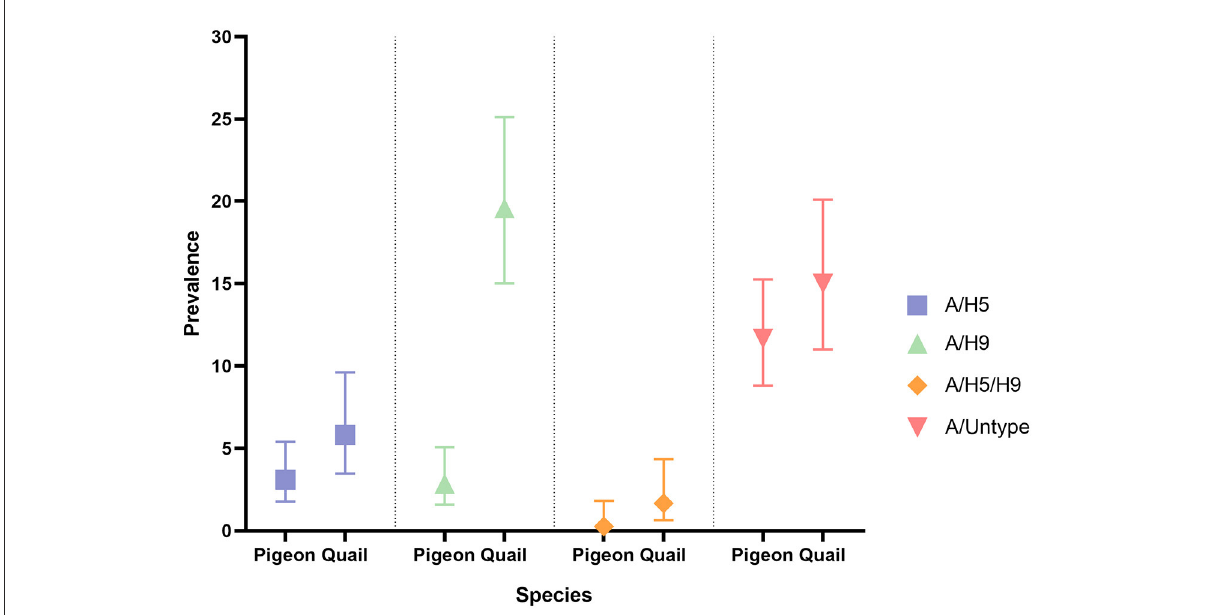
FIGURE2 Prevalence and 95% CI of Influenza A subtypes in pigeons and